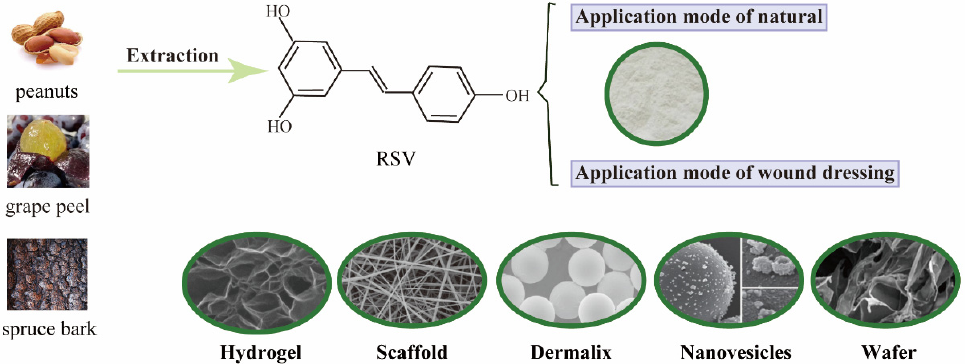
Figure 1. The native and wound dressing modes of RSV.